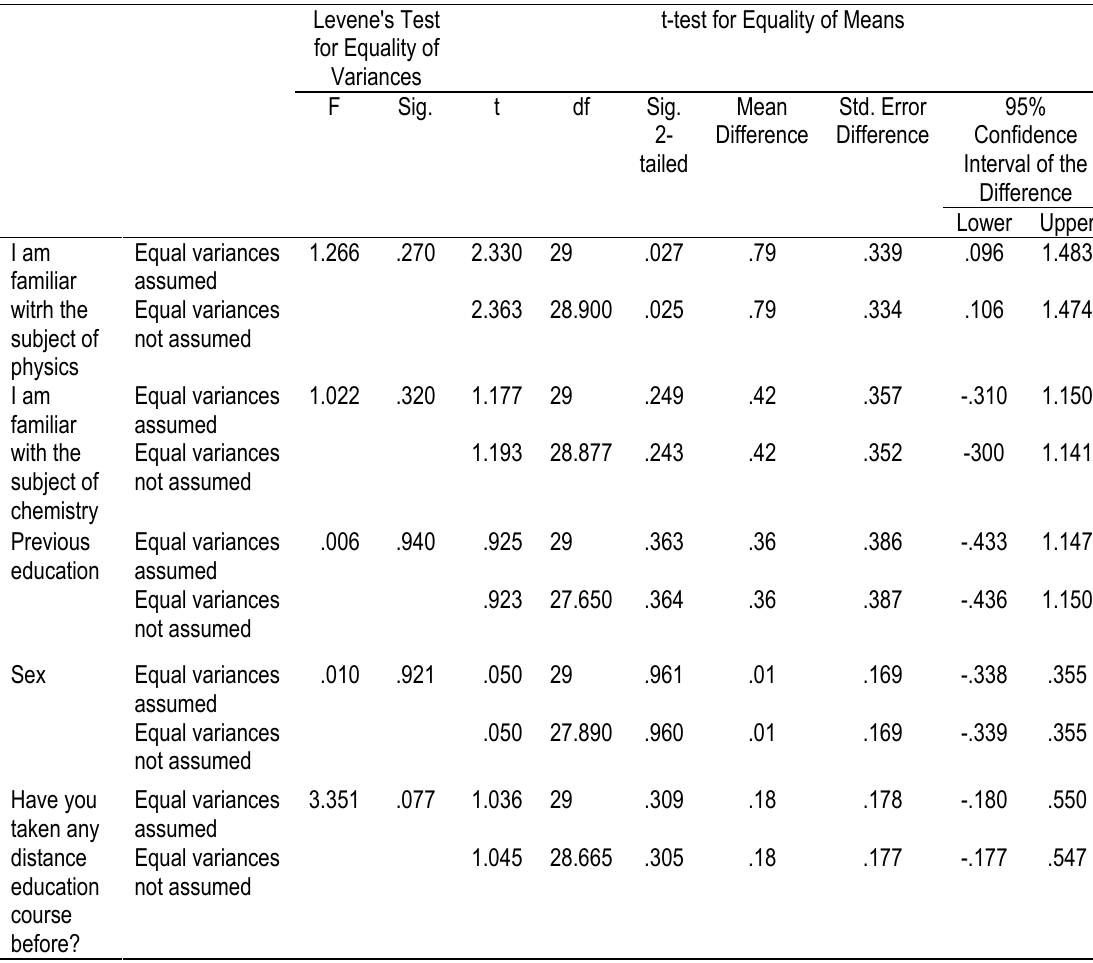
Table 7. Independent Samples